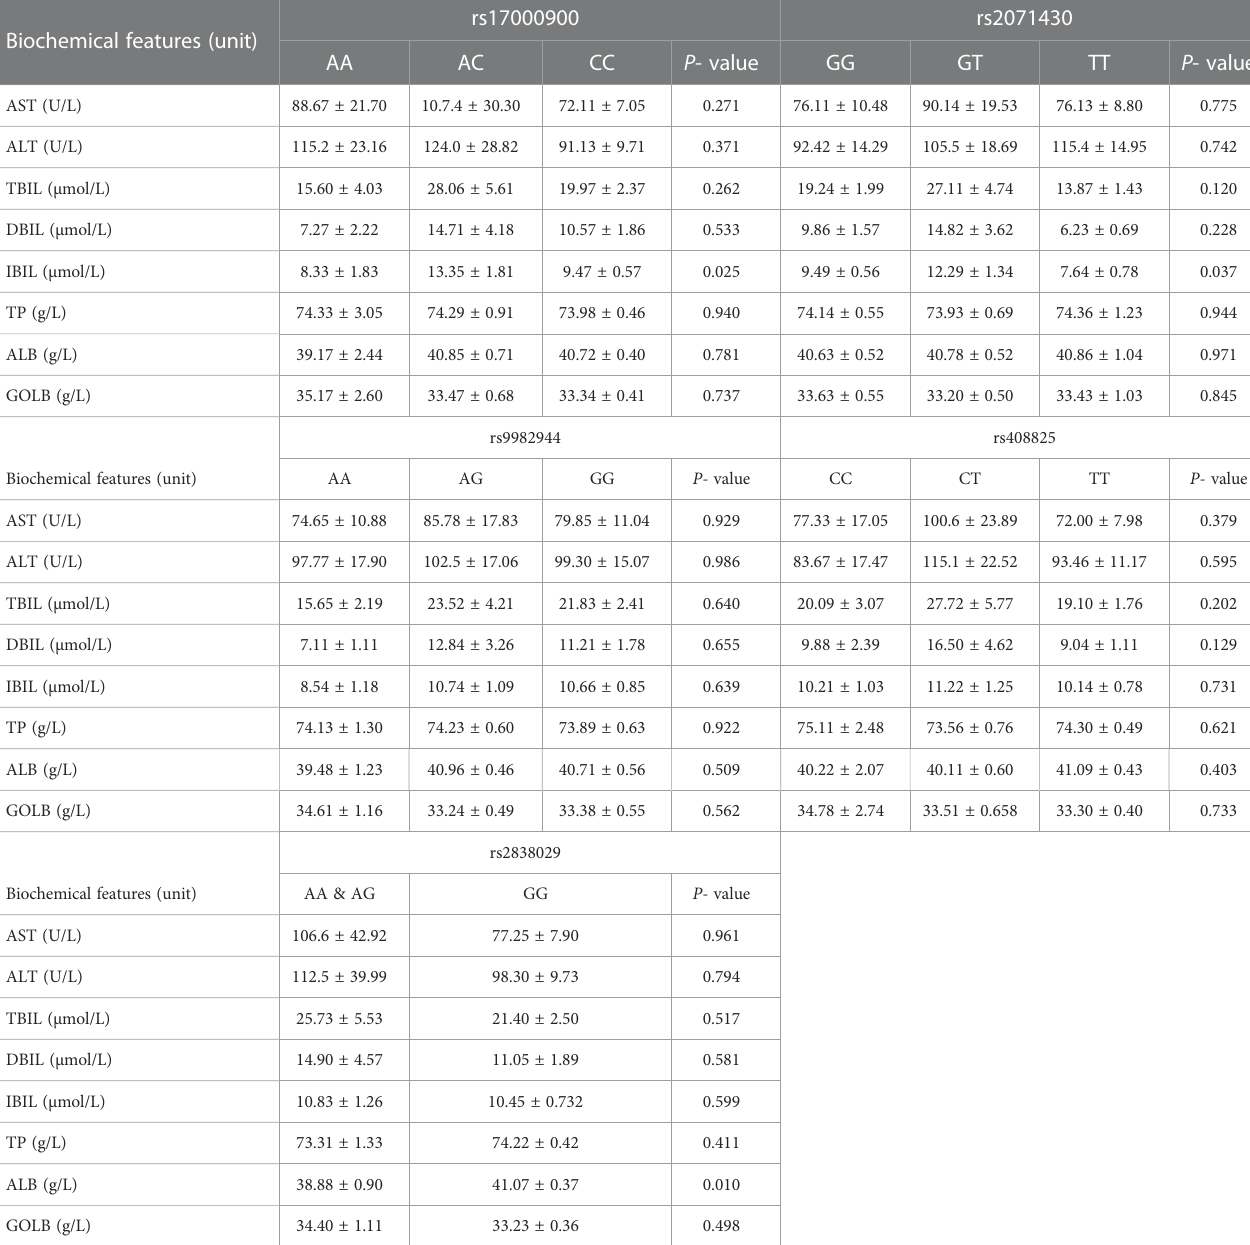
TABLE 2 Biochemical indexes analysis among HCV patients with various SNP genotypes.